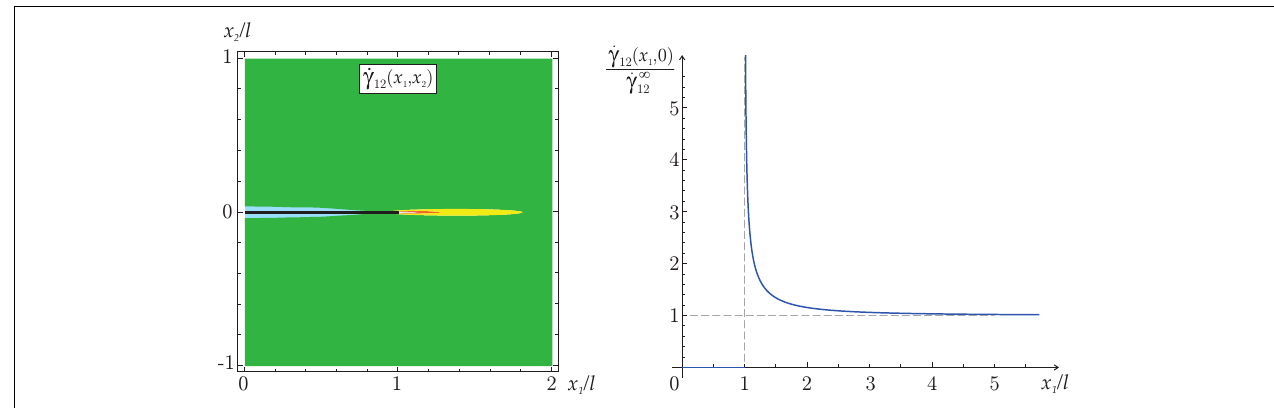
FIGURE 16 | Incremental shear strain near a shear band obtained through the perturbative approach: level sets (left) and behavior along the x 1 -axis (right)